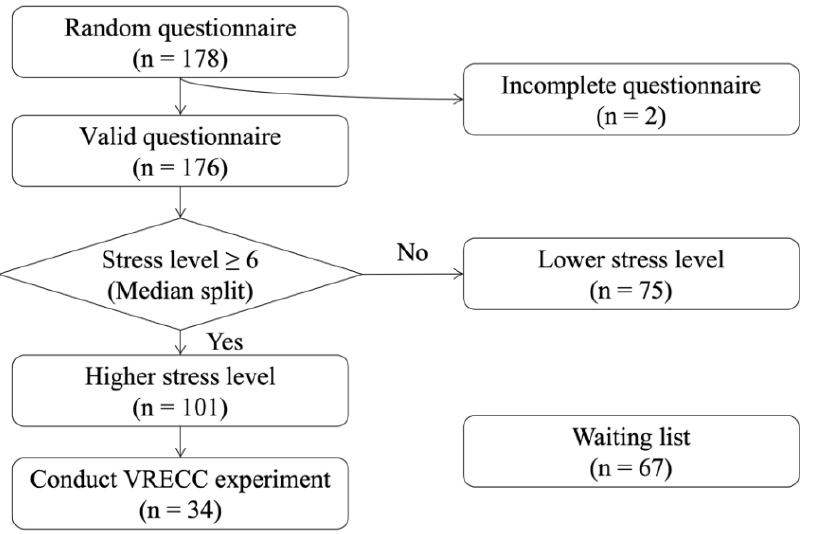
Figure 8. VRECC subject selection process flow.